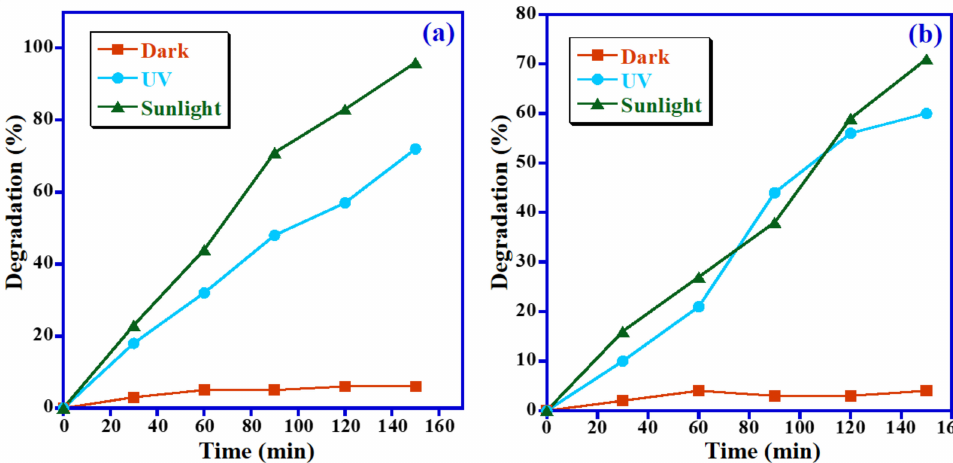
Figure 8. Influence of light source on photodecomposition of ( a ) MB and ( b )